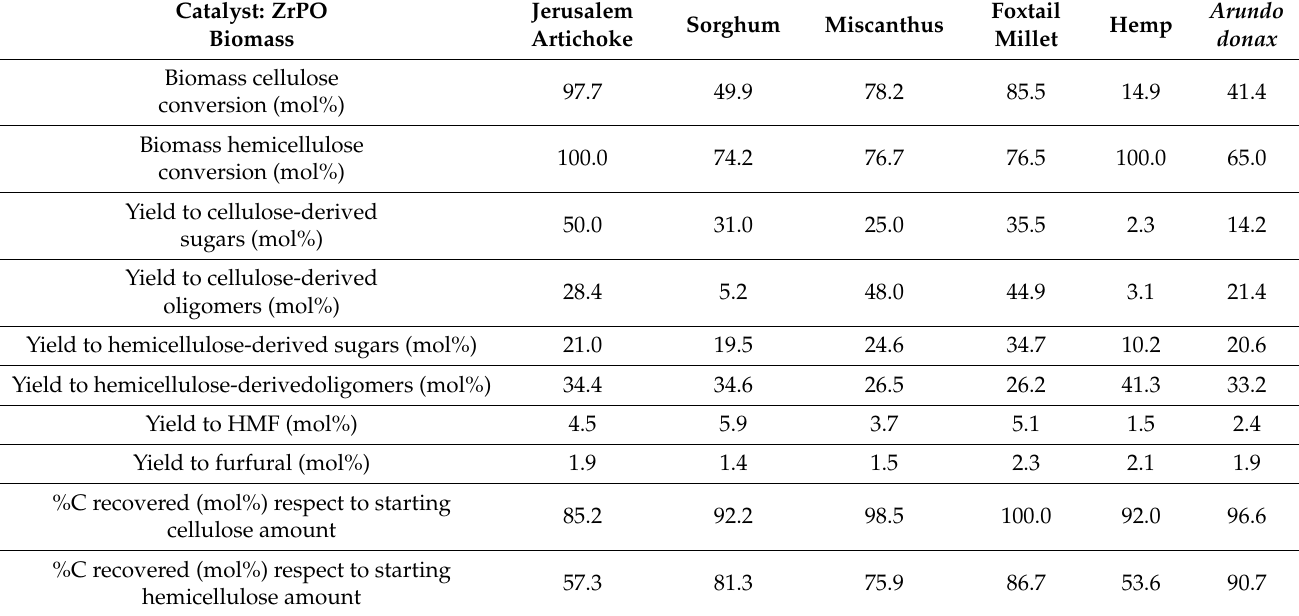
Table 10. Catalytic performances of ZrPO in the conversion of lignocellulosic biomasses at 150 ◦